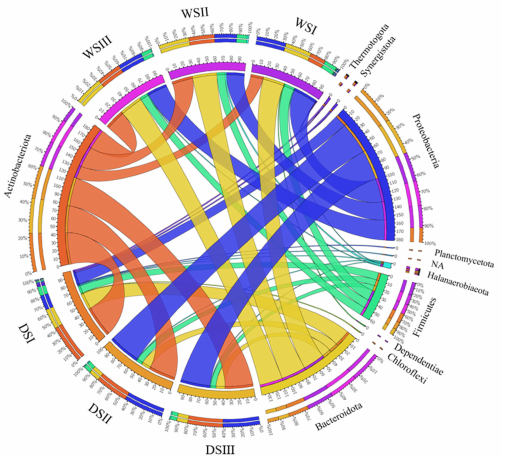
Figure 5. Circos diagrams showing the connection among salt samples and main prokaryotic phyla. The ribbons show ribbon contribution for each segment. Only taxonomic groups with relative abundance >1% are represented here. WS , white salt; DS , dark salt.